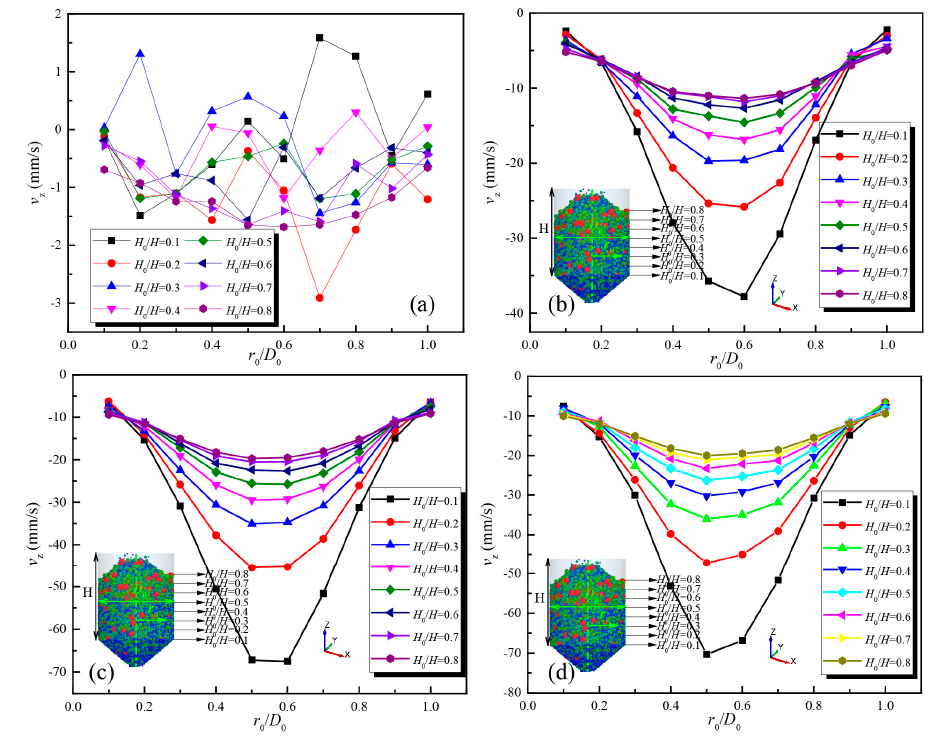
Figure 10. The variation in sinter layer velocity with different normalized outlets of ( a ) d 0 / D 0 = 0.1, ( b ) d 0 / D 0 = 0.2, ( c ) d 0 / D 0 = 0.3, and ( d ) d 0 / D 0 = 0.4.